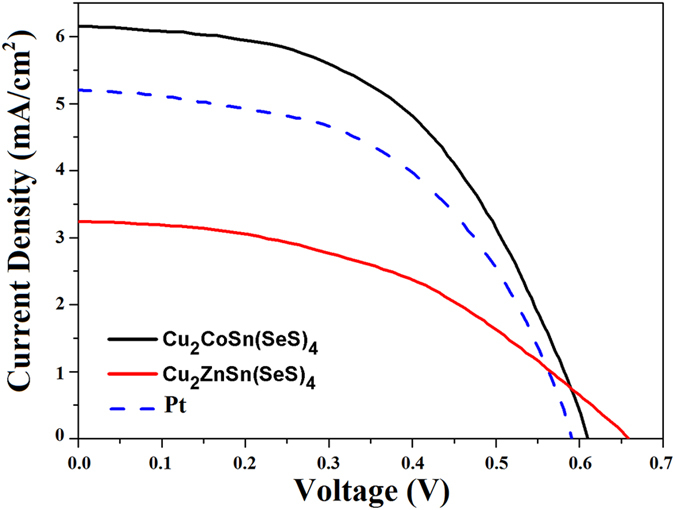
J–V characteristics of DSSCs employing Cu2CoSn(SeS)4 and Cu2ZnSn(SeS)4 nanocrystals- and Pt-based counter electrodes.